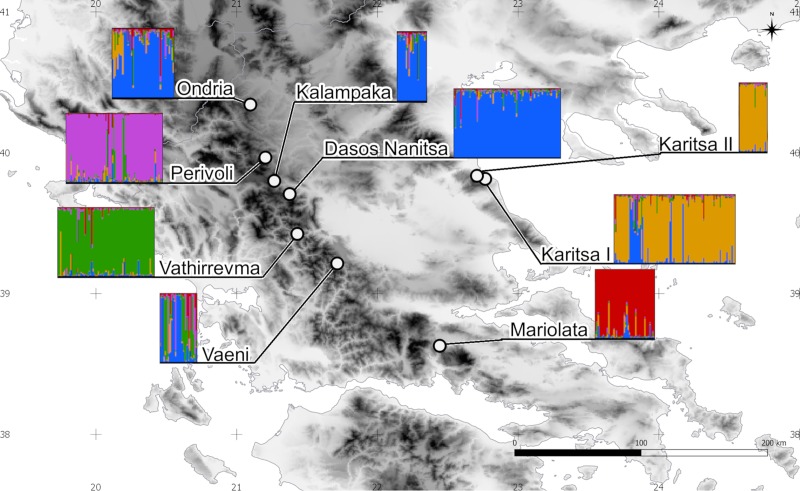
Location of the sampled populations with results of clustering analyses made with STRUCTURE.